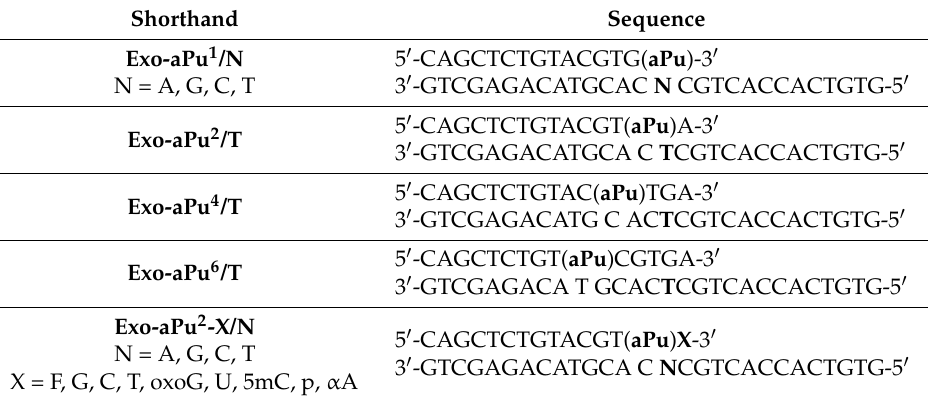
Table 3. DNA duplexes used as substrates and ligands of